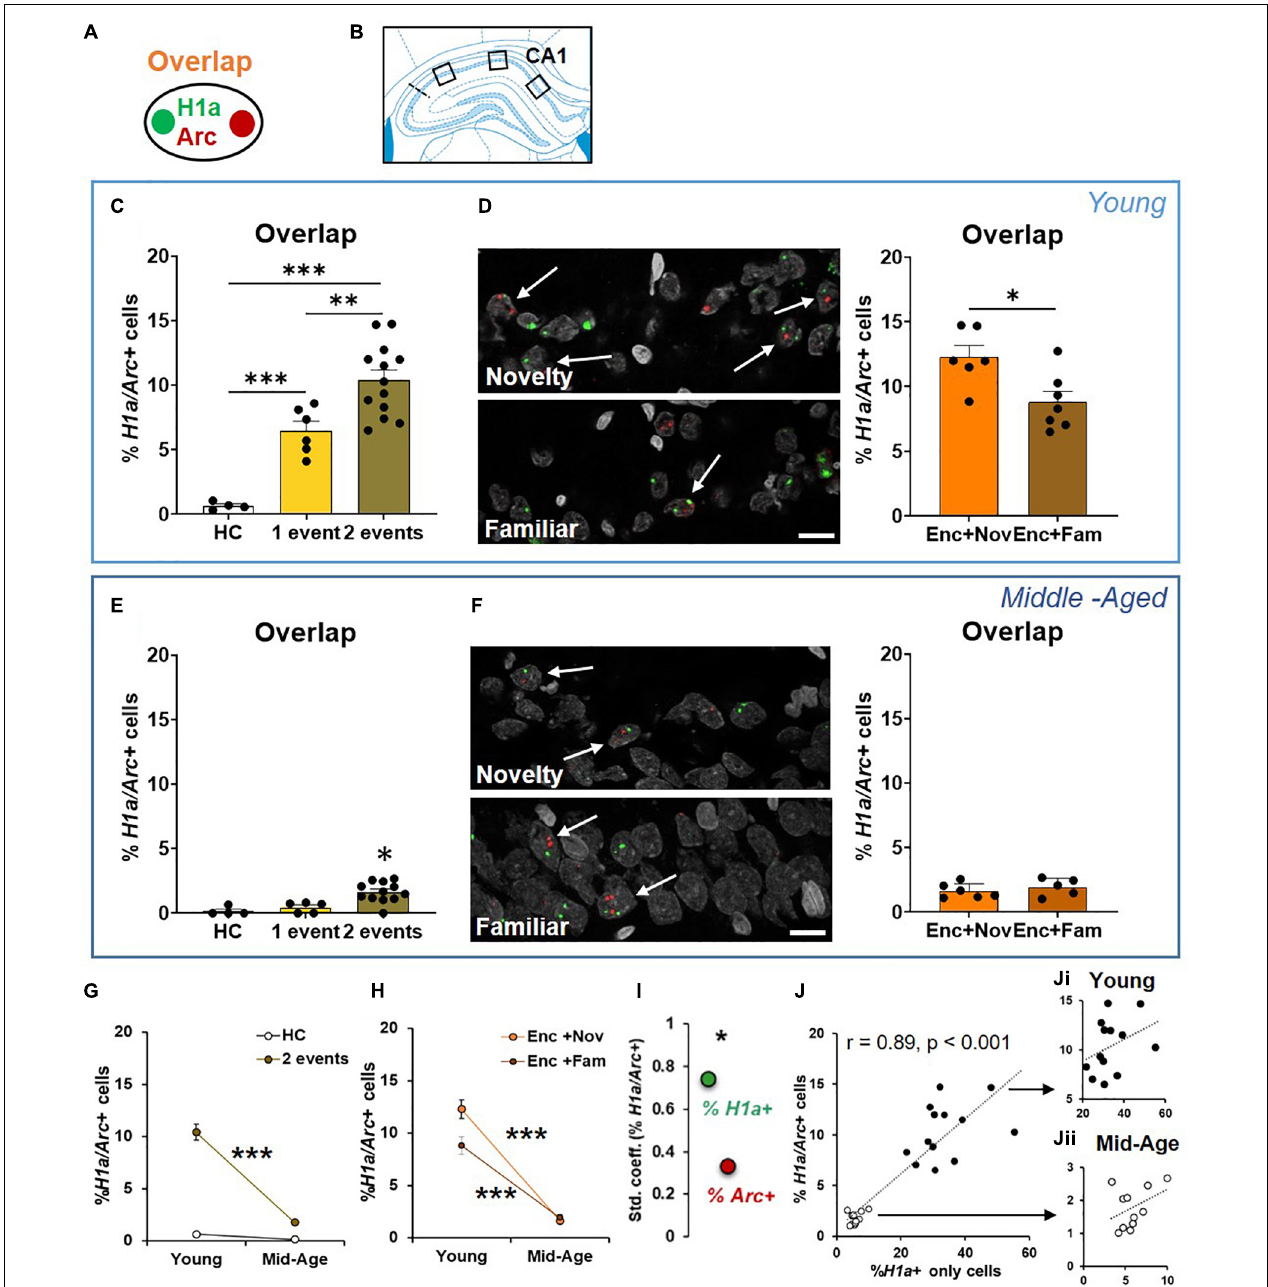
FIGURE 5 | The cellular signature underpinning behavioral tagging is altered in aging. (A) Neurons activated by epoch 1 and epoch 2 were referred to as H1a/Arc +. (B) Images were collected in 3 areas of CA1. (C) In the young rats, the percentage of H1a / Arc + CA1 neurons was highest in the rats receiving 2 events (Enc + Nov and Enc + Fam, 1 event = the rats exposed only to ADMP encoding or to novel box exploration). (D) An example and percentage of H1a / Arc + CA1 neurons after novelty or familiarity exploration in the young rats. A scale bar: 10 µ m. The percentage of neurons activated in the Enc + Nov group was higher than in the Enc + Fam group. (E) In the middle-aged rats, the percentage of H1a / Arc + CA1 neurons was highest in the rats receiving 2 events (Enc + Nov and Enc + Fam, 1 event = the rats exposed only to ADMP encoding). (F) Example images and percentage of H1a / Arc + CA1 neurons with novelty or familiarity exploration after ADMP encoding in the middle-aged rats. A scale bar: 10 µ m. No difference was observed between the rats exposed to a novel or a familiar box. (G) The percentage of H1a/Arc + CA1 neurons decreased with aging after 2 events exposure. (H) The percentage of H1a / Arc + CA1 neurons in two sub-groups decreased with aging. (I) The standardized coefficients between the percentages of H1a / Arc + and H1a + neurons (0.74) were significantly larger than which between the percentage of H1a / Arc + and Arc + neurons (0.33). (J) Correlation between the H1a + only neuronal population activated by ADMP encoding and the overlapping H1a/Arc + population (black: young, white: middle-aged). (Ji) Correlation in the young rats. (Jii) Correlation in the middle-aged rats. Data are presented as mean ± SEM. * p < 0.05, ** p < 0.01, and *** p < 0.005.